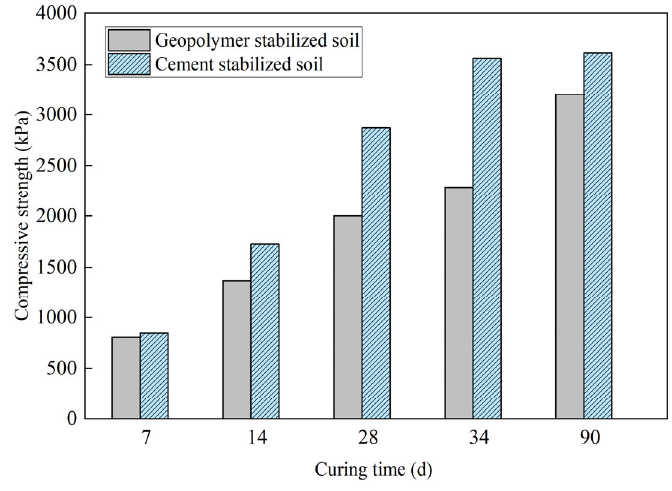
Figure 4. Compressive strength of the soil stabilized by geopolymer and OPC.